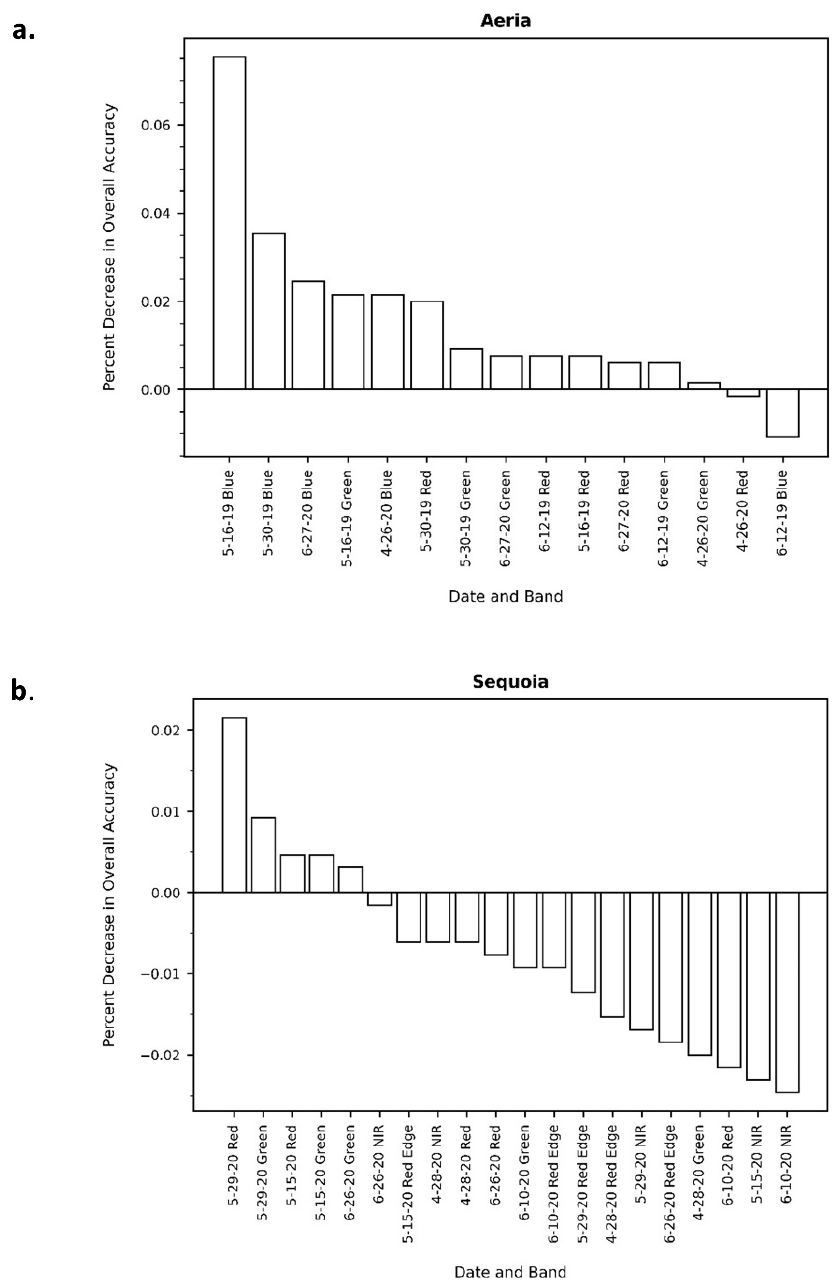
Figure 6. Feature importance values for the ( a ) Aeria and ( b ) Sequoia sensors. Feature importance was measured as the decrease in overall accuracy of the baseline model when that band was removed from the model. Positive values indicate a decrease in accuracy while negative values indicate an increase is accuracy.